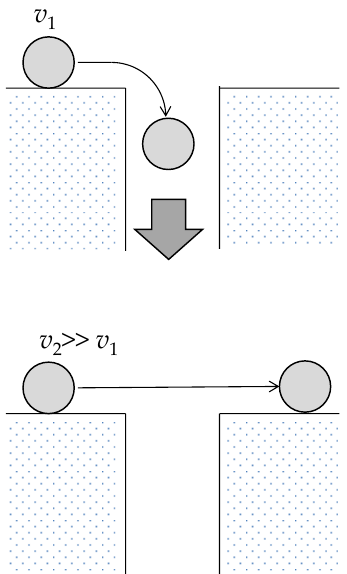
Figure 2. Movement of balls in a golf game: Balls can fall into the hole or not depending on their velocity ( v 2 >> v 1 ).